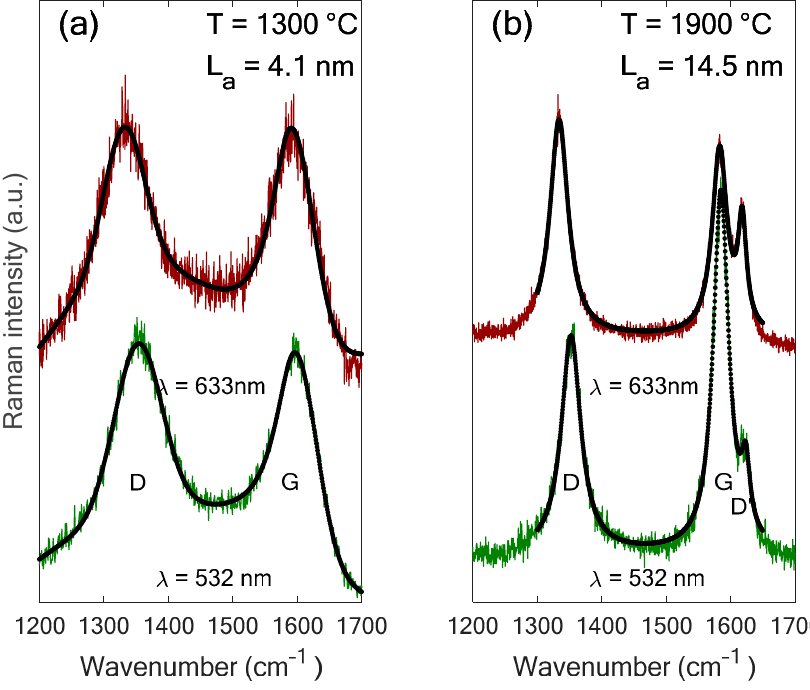
Figure 6. Raman spectra of annealed cokes (left: 1300 °C; right: 1900 °C) for two excitation wavelengths. The fits are the solid black line.